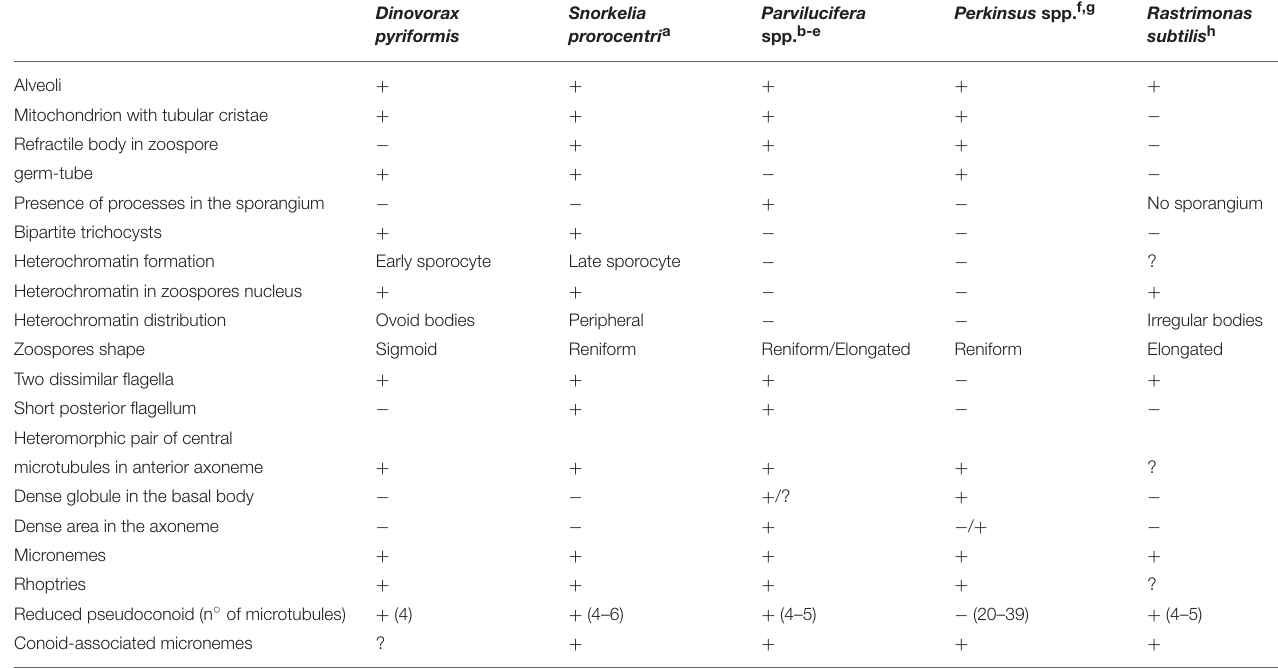
TABLE 1 | Comparison of the morphological characters of Dinovorax pyriformis with other